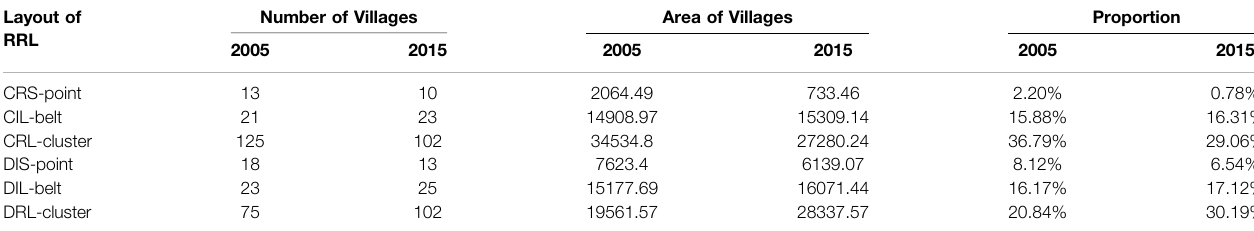
TABLE 3 | The number and area of pattern types of rural residential land in Pinggu from 2005 to 2015.